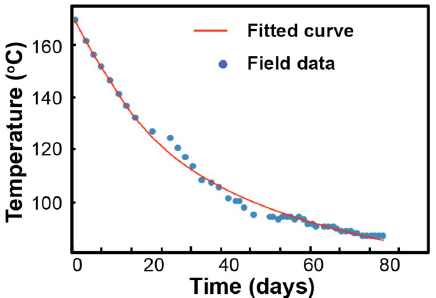
Figure 11. Curve fitting to temperature decline curve from Fenton Hill Phase I reservoir. Geosciences 2019 , 9 , x FOR PEER REVIEW